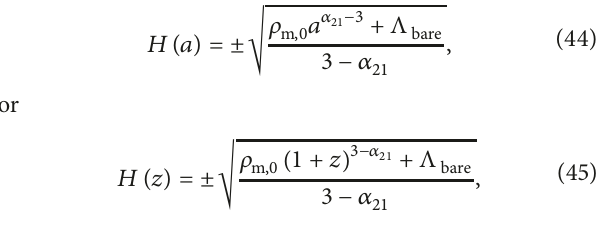
Figure 3: The diagram of the evolution of the Hubble function with respect to the cosmological time 𝑡 , which is described by (40) and (43) with 𝛼 21 ̸= 0 and 𝛼 2𝑛 = 0 for every 𝑛 > 1 . For illustration, the value of the parameter 𝛼 21 = is chosen as −0.3 . The top blue curve describes the evolution of the Hubble function in the Λ CDM model. The middle curve describes one for (43) and the bottom red curve describes one for (40). The Hubble function is expressed in km / s Mpc and the cosmological time 𝑡 is expressed in s Mpc / km. Note that these models are not qualitatively